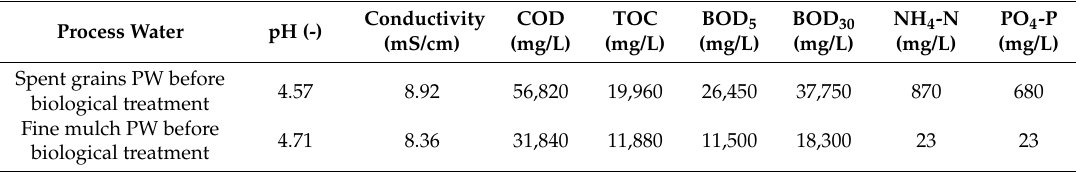
Conductivity COD TOC BOD 5 BOD 30 NH 4 -N PO 4 -P (mS/cm) (mg/L) (mg/L) (mg/L) (mg/L) (mg/L) (mg/L) 4.57